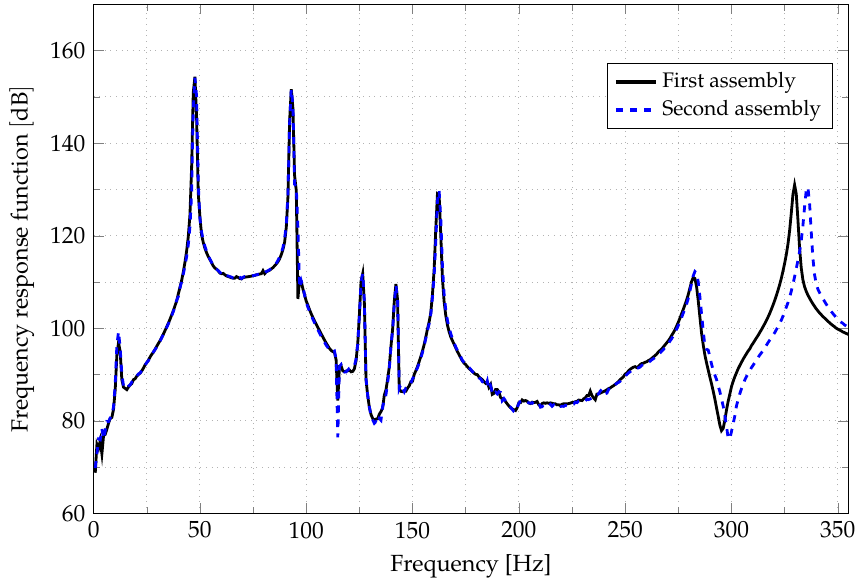
Figure A1. FRF of the reference test specimen.